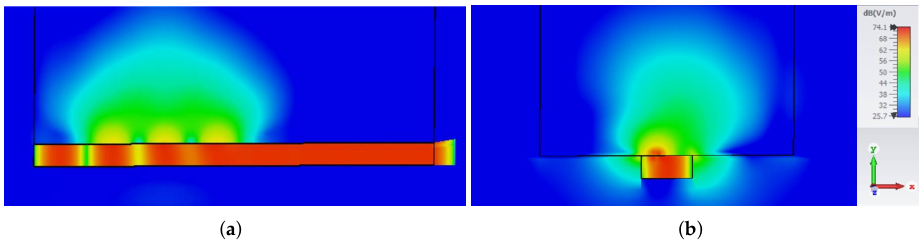
Figure 16. Antenna radiating into the human body—distribution of the E-field magnitude: ( a ) H-plane cross-section, ( b ) E-plane cross-section. The black frame indicates the cuboid phantom.